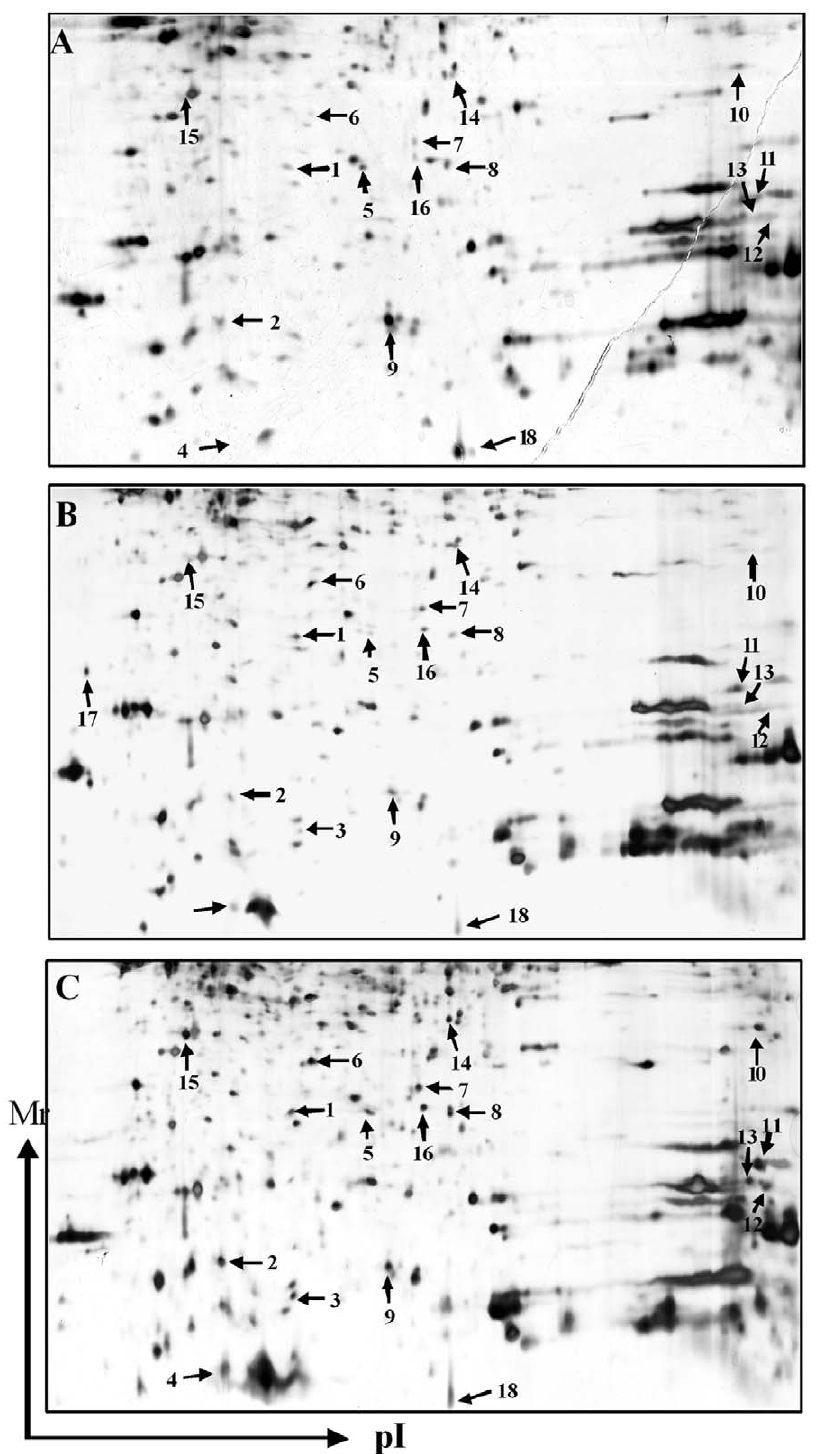
Figure 1. Representative 2D gels. Control group(upper), LPS + Intralipid group(middle) and LPS + propofol group(lower). Fifteen of these protein spots were successfully identified by MALDI-TOF MSMS and by subsequent comparative sequence search in the Mascot database.